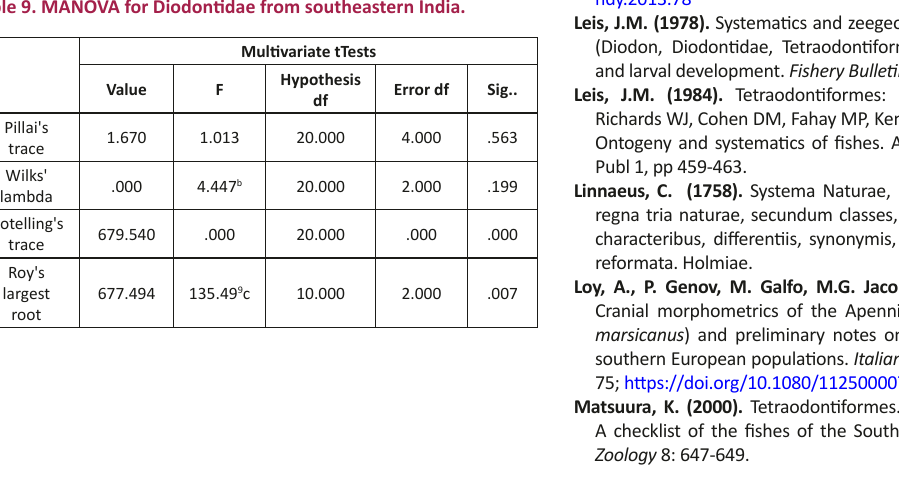
Table 9. MANOVA for Diodontidae from southeastern